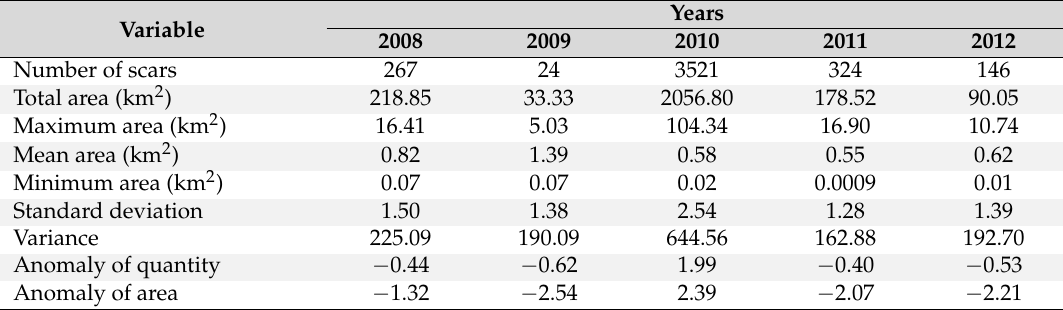
Table A4. Summary of burned scars between 2008 and 2012 for Acres state.